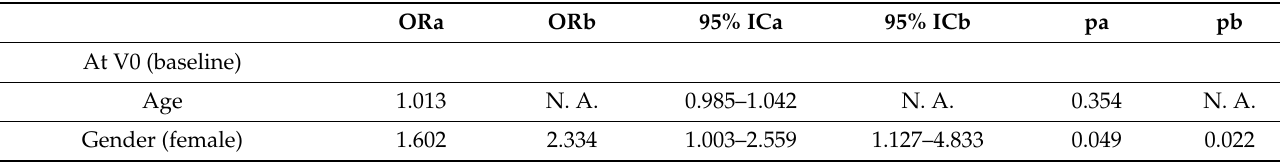
Figure 3. Predictors of functional disability (S&E-ADLS score < 80%) at V2. Light grey arrows show the OR of variables from baseline visit (V0). Dark grey arrows show the OR of change of variables from V0 to V2. Red arrows with discontinue line represent the 95%CI. BDI-II, Beck Depression Inventory-II; DD, disease duration; FOGQ, Freezing Of Gait Questionnaire; PD-CRS, Parkinson’s Disease Cognitive Rating Scale; VAFS, Visual Analog Fatigue Scale. Table 4. Factors associated with functional dependency at V2 (S&E-ADLS score < 80%). ORa